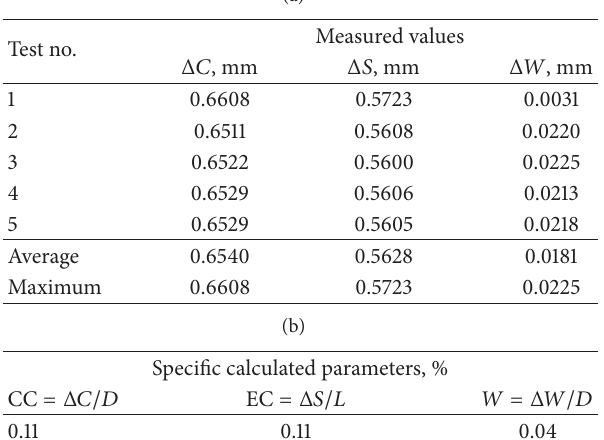
Table 4: The classification results of tile third specimen.